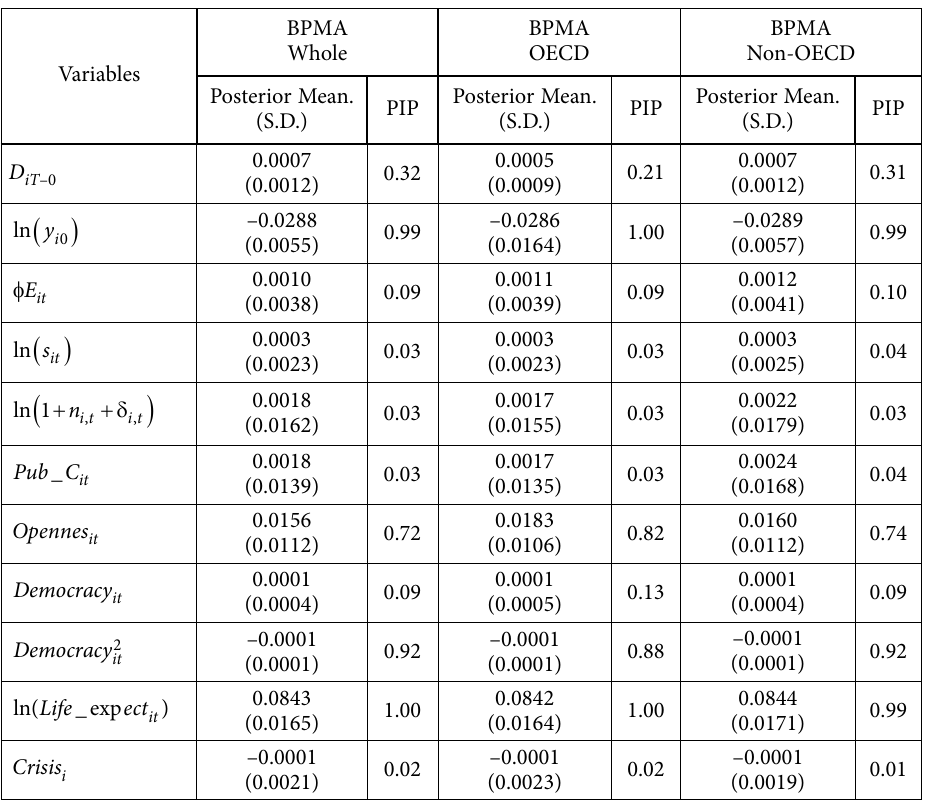
Table 2. BPMA analysis, correcting